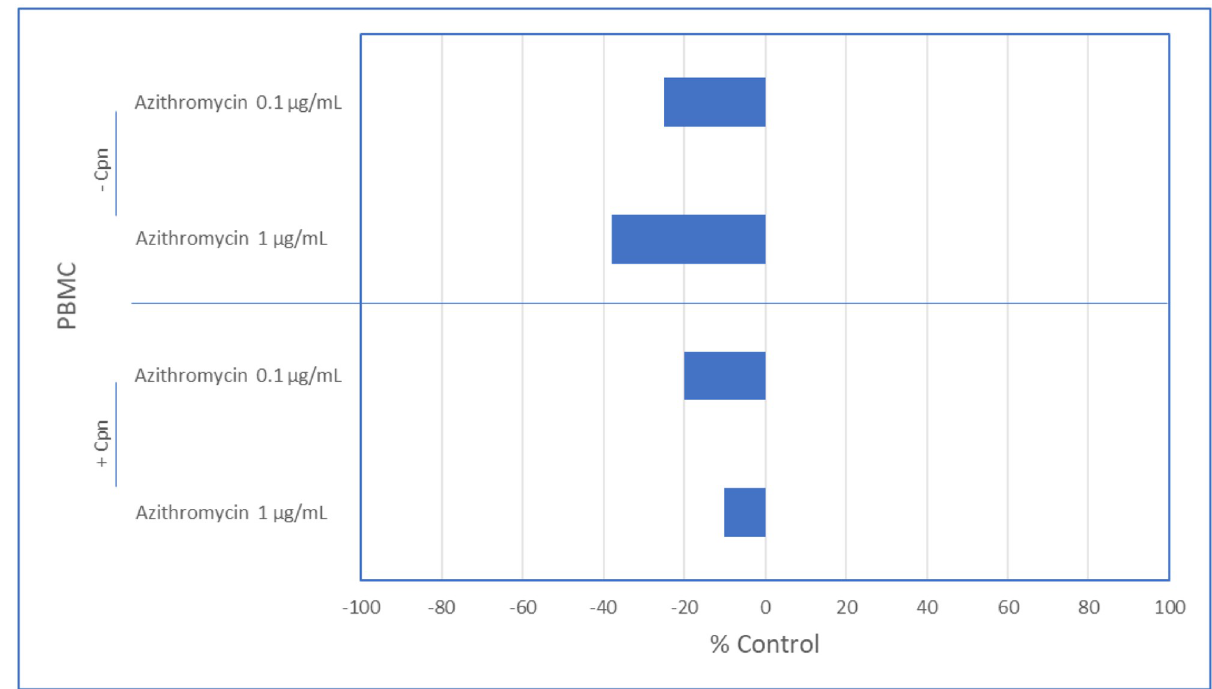
Fig 1. Effect of azithromycin on Chlamydia pneumoniae mediated IL-4 responses. Data represented as percent control. P > 0.05, in all cases (Mann- Whitney U Test).